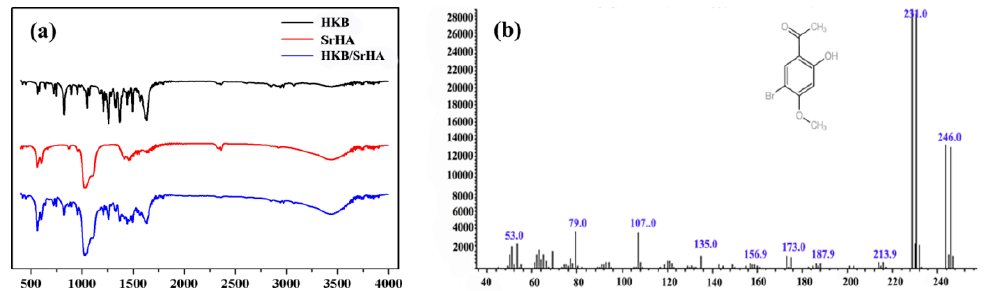
Figure 2. ( a ) FTIR spectra of 1-(5-bromo-2-hydroxy-4-methoxyphenyl)-ethanone (HKB), SrHA and HKB/ SrHA; ( b ) EIMS spectra data for HKB.